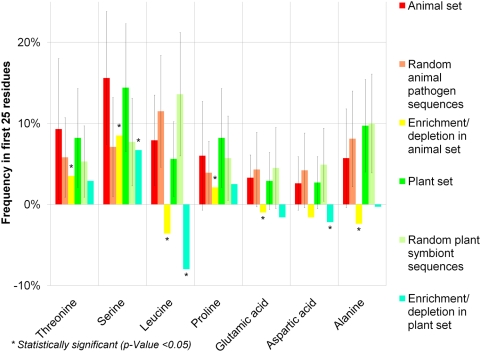
Enrichment of amino acids in effector N-termini.Amino acids that are significantly enriched or depleted in the first 25 residues of effectors from the animal pathogen effector set and from the plant symbiont effector set (p-Value<0.05 in the one sided Mann-Whitney test in at least one of the sets). Frequencies are given as percentage of amino acids within the 25 first residues. Error bars represent one standard deviation in plus and one standard deviation in minus directions.